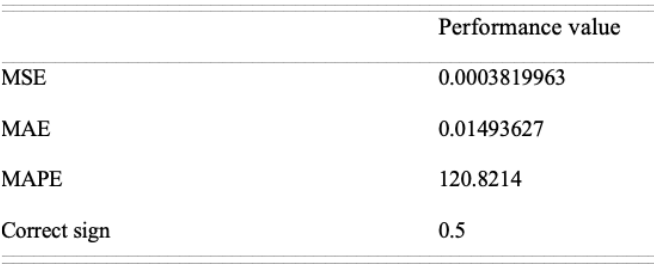
Table 8: Forecasting performance through MSE, MAE, MAPE and correct sign prediction criterion